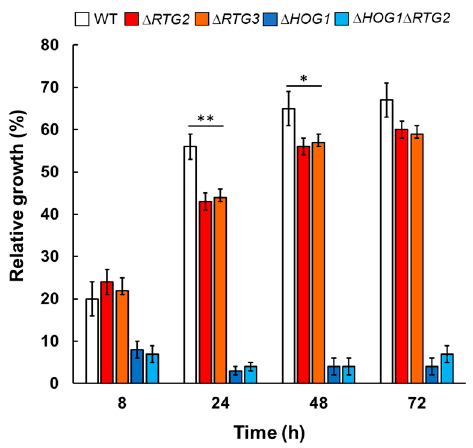
Figure 4. Relative growth of wild-type and mutant cells in batch cultures in the presence of sodium chloride. Wild-type (WT) and mutant cells ( ∆ RTG2 , ∆ HOG1 , ∆ HOG1 ∆ RTG2 and ∆ RTG3 ), grown overnight in YPD medium, were diluted to 0.1 OD 600 in fresh liquid YPD with or without 0.8 M sodium chloride (NaCl), and optical density (OD 600 ) was measured at 600 nm at the indicated times. Relative growth was calculated as the percentage of the OD 600 of stressed/control cells. Unpaired Student’s t -test: statistical significance differences with ** p < 0.01 and * p < 0.05 when comparing wild type with RTG mutants from six independent experiments at 24 h.